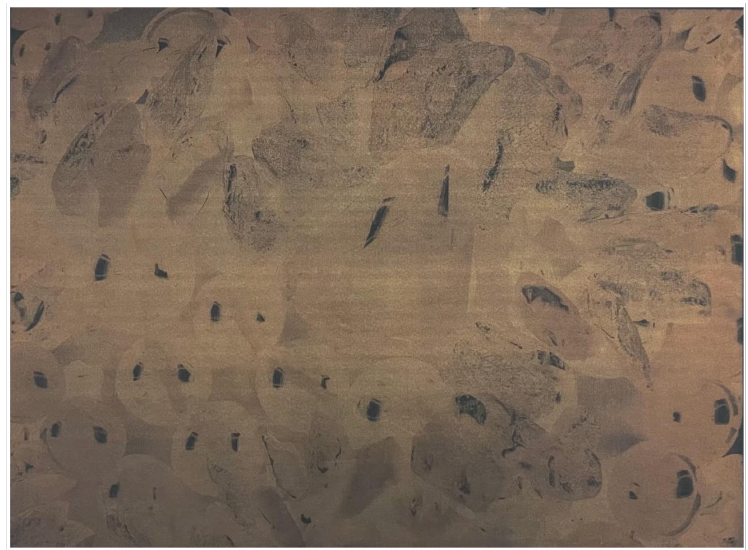
Figure A6. 25LPI, offset litho, C = Iriodin™ Icy White, B = Iriodin™ Platinum Gold, M = Iriodin™ Solar Gold, Y = Pyrisma™ Ambercup Orange, printed light to dark, black Plike, film positive, print size: 600 mm × 450 mm.